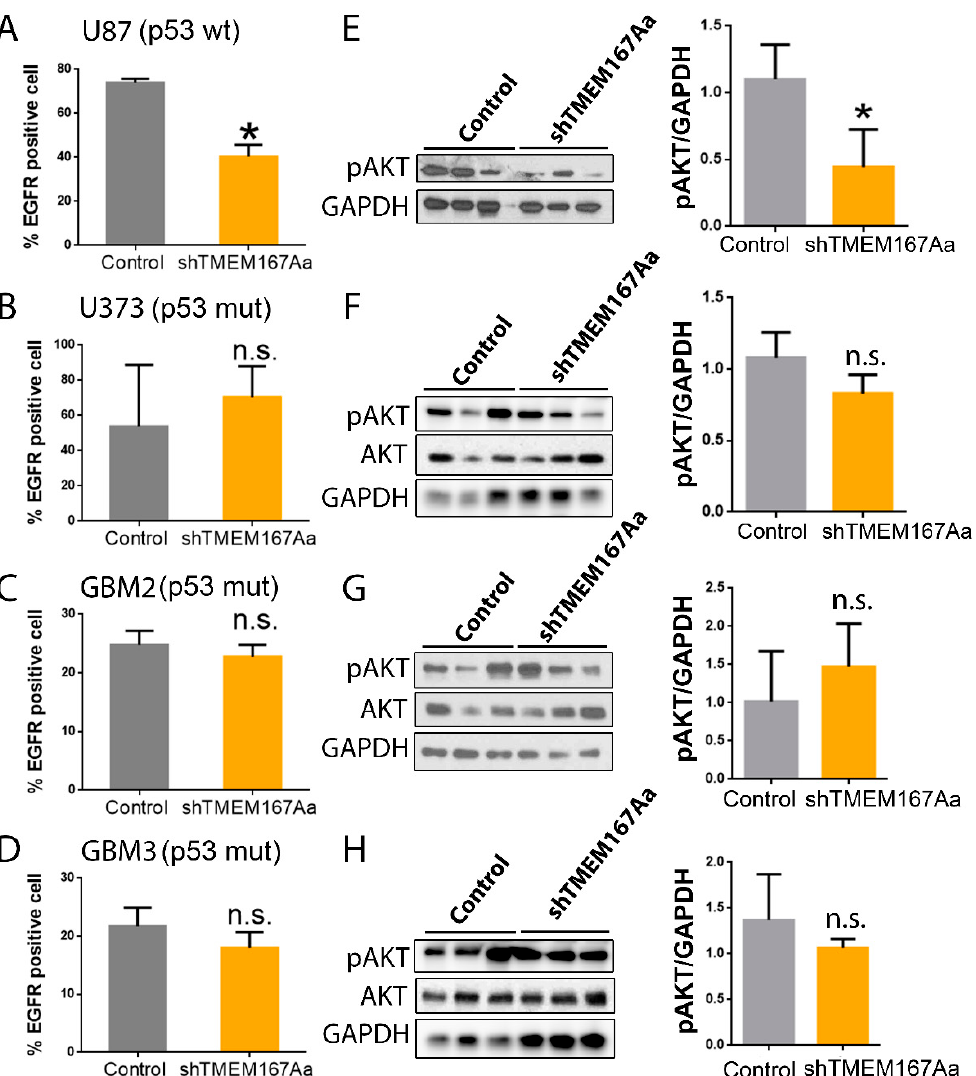
Figure 4. TMEM167A knockdown impairs EGFR stability and AKT signaling in wild-type p53 gliomas. ( A – D ) Flow cytometry analysis of the number of EGFR positive cells (%) in subcutaneous tumors from Figure 4C–F. ( E – H ) WB analysis and quantification of pSer473-AKT (pAKT) in tumors from Figure 4C–F. GADPH was used as a loading control. * p ≤ 0.05, n.s. = nonsignificant.